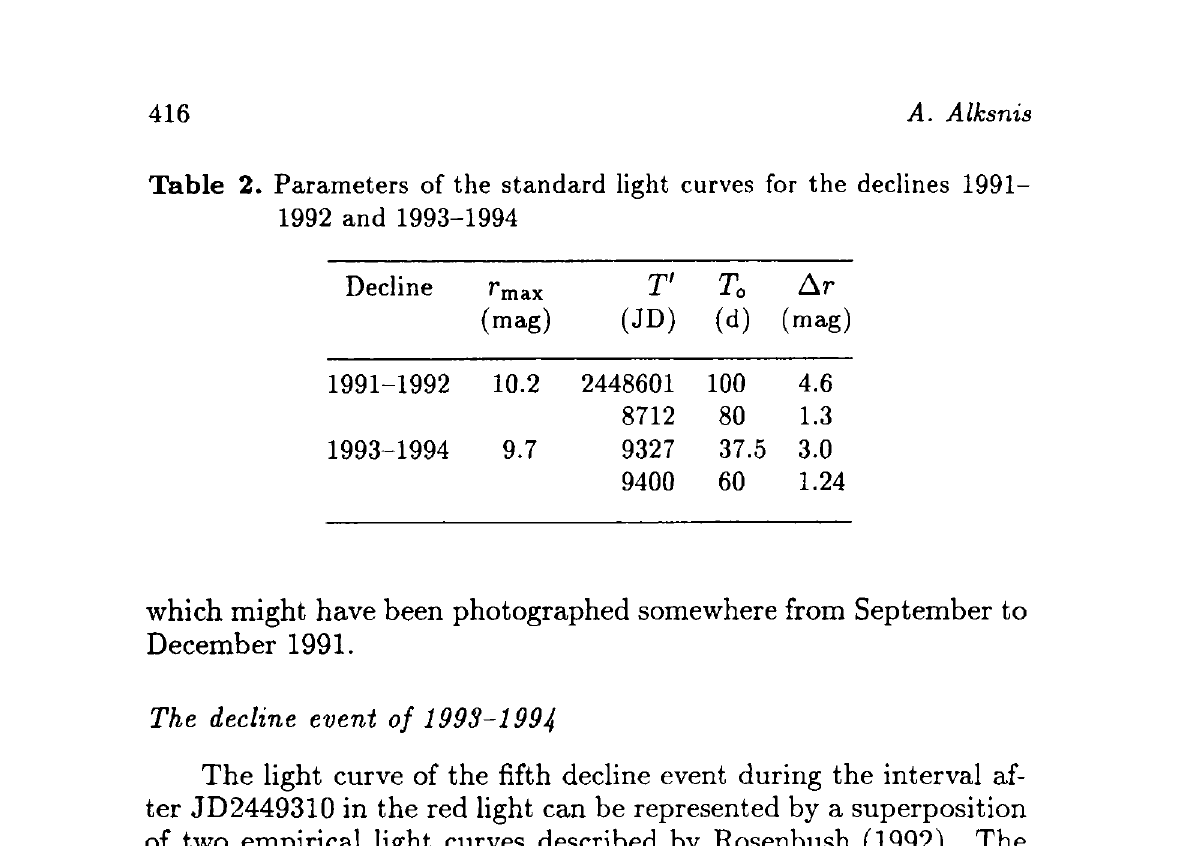
Table 2. Parameters of the standard light curves for the declines